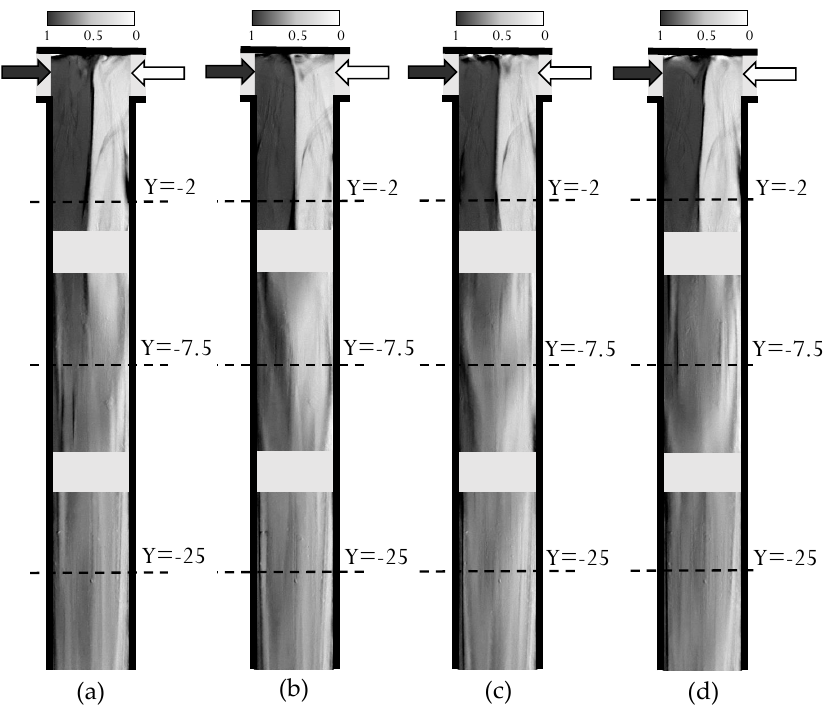
Figure 4. Experimental depth-averaged MB + concentration at Re = 650 for instants: ( a ) t / τ = 0, ( b ) t / τ = 0.25, ( c ) t / τ = 0.50, ( d ) t / τ =